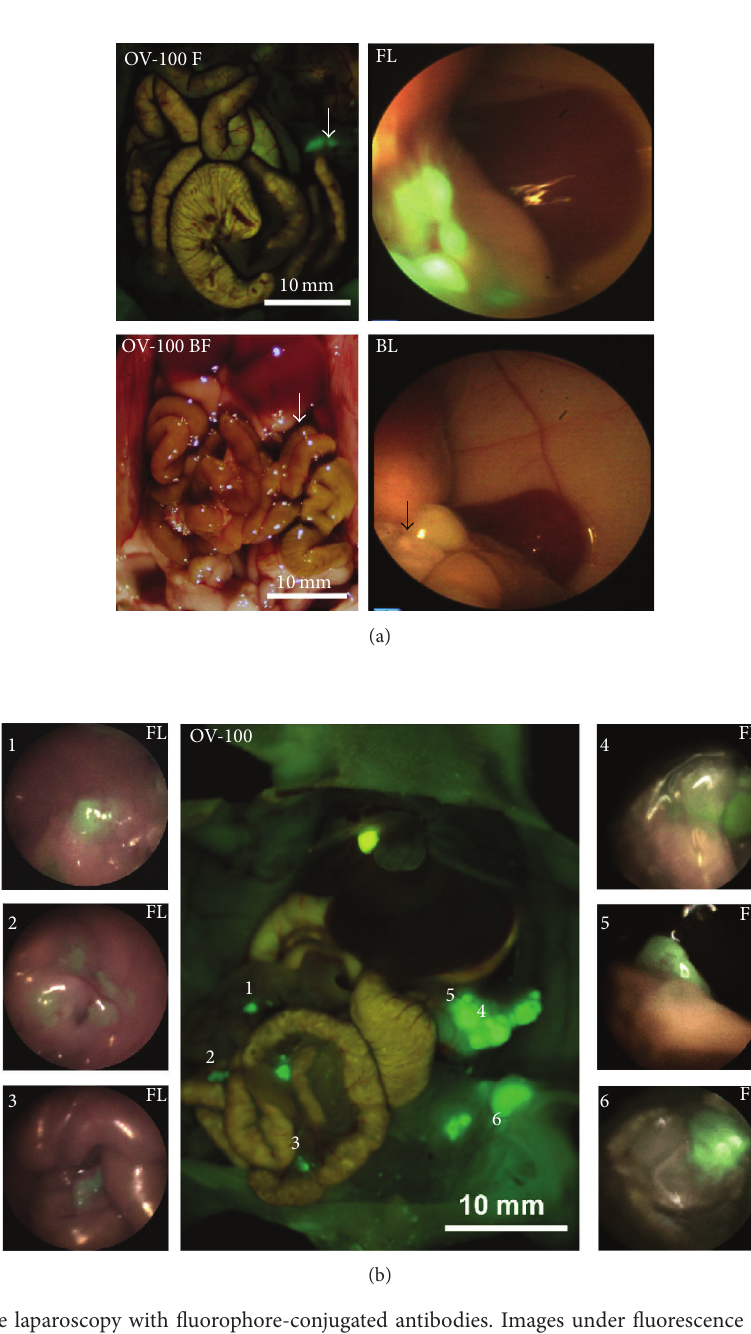
Figure 2: (a) Fluorescence laparoscopy with fluorophore-conjugated antibodies. Images under fluorescence and bright field laparoscopy visualized the primary tumor in the body of the pancreas. The two images on the left are positive control images taken with the Olympus OV-100smallanimalimagingsystemforcomparisonwithlaparoscopicimagesontherightunderfluorescence(top)andbrightfield(bottom). The primary pancreatic tumor was more easily detected under fluorescence laparoscopy (FL) compared to bright field laparoscopy (BL) [2]. (b) Use of fluorescence laparoscopy to identify primary and metastatic lesions. The center image is a positive control OV-100 image for comparison with BL and FL. The surrounding images, labeled 1–6, are representative FL images of primary and metastatic pancreatic tumor lesions. The numbers in the upper left corner of each picture correspond to the numbered lesion in the center OV-100 image